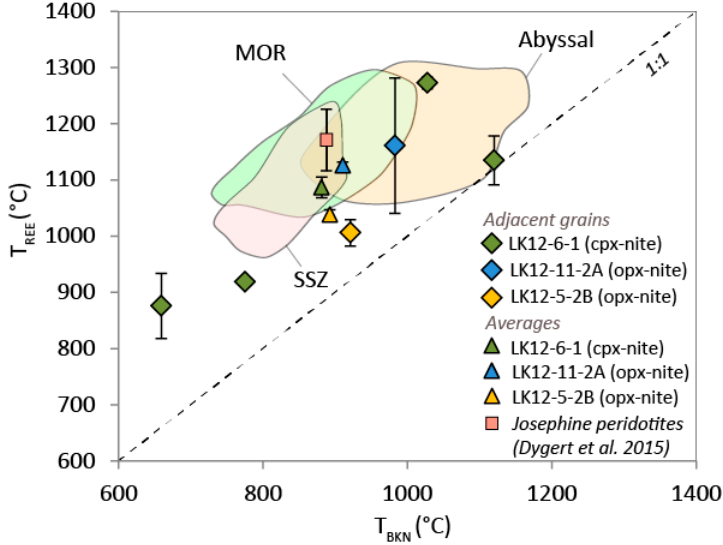
Figure 9. REE and major element equilibration temperatures derived from average grain compositions and adjacent analyses only in Josephine pyroxenites, compared to REE temperatures for Josephine peridotites, MOR ophiolitic peridotites, supra-subduction zone (SSZ) peridotites, and abyssal peridotites [53]. Error bars on T REE represent 1SD derived from regression diagrams [52], which indirectly reflects the number of analyses, analytical error, and internal variability. “Adjacent grains” temperatures usually have larger error because they are derived from a limited number of OPX-CPX analyses right next to the grain boundary.